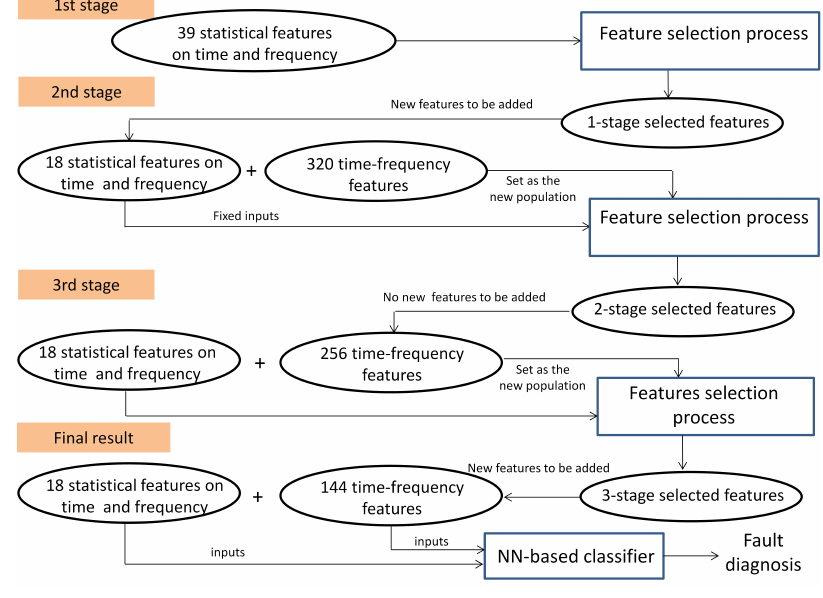
Figure 8. Case study: Final results.